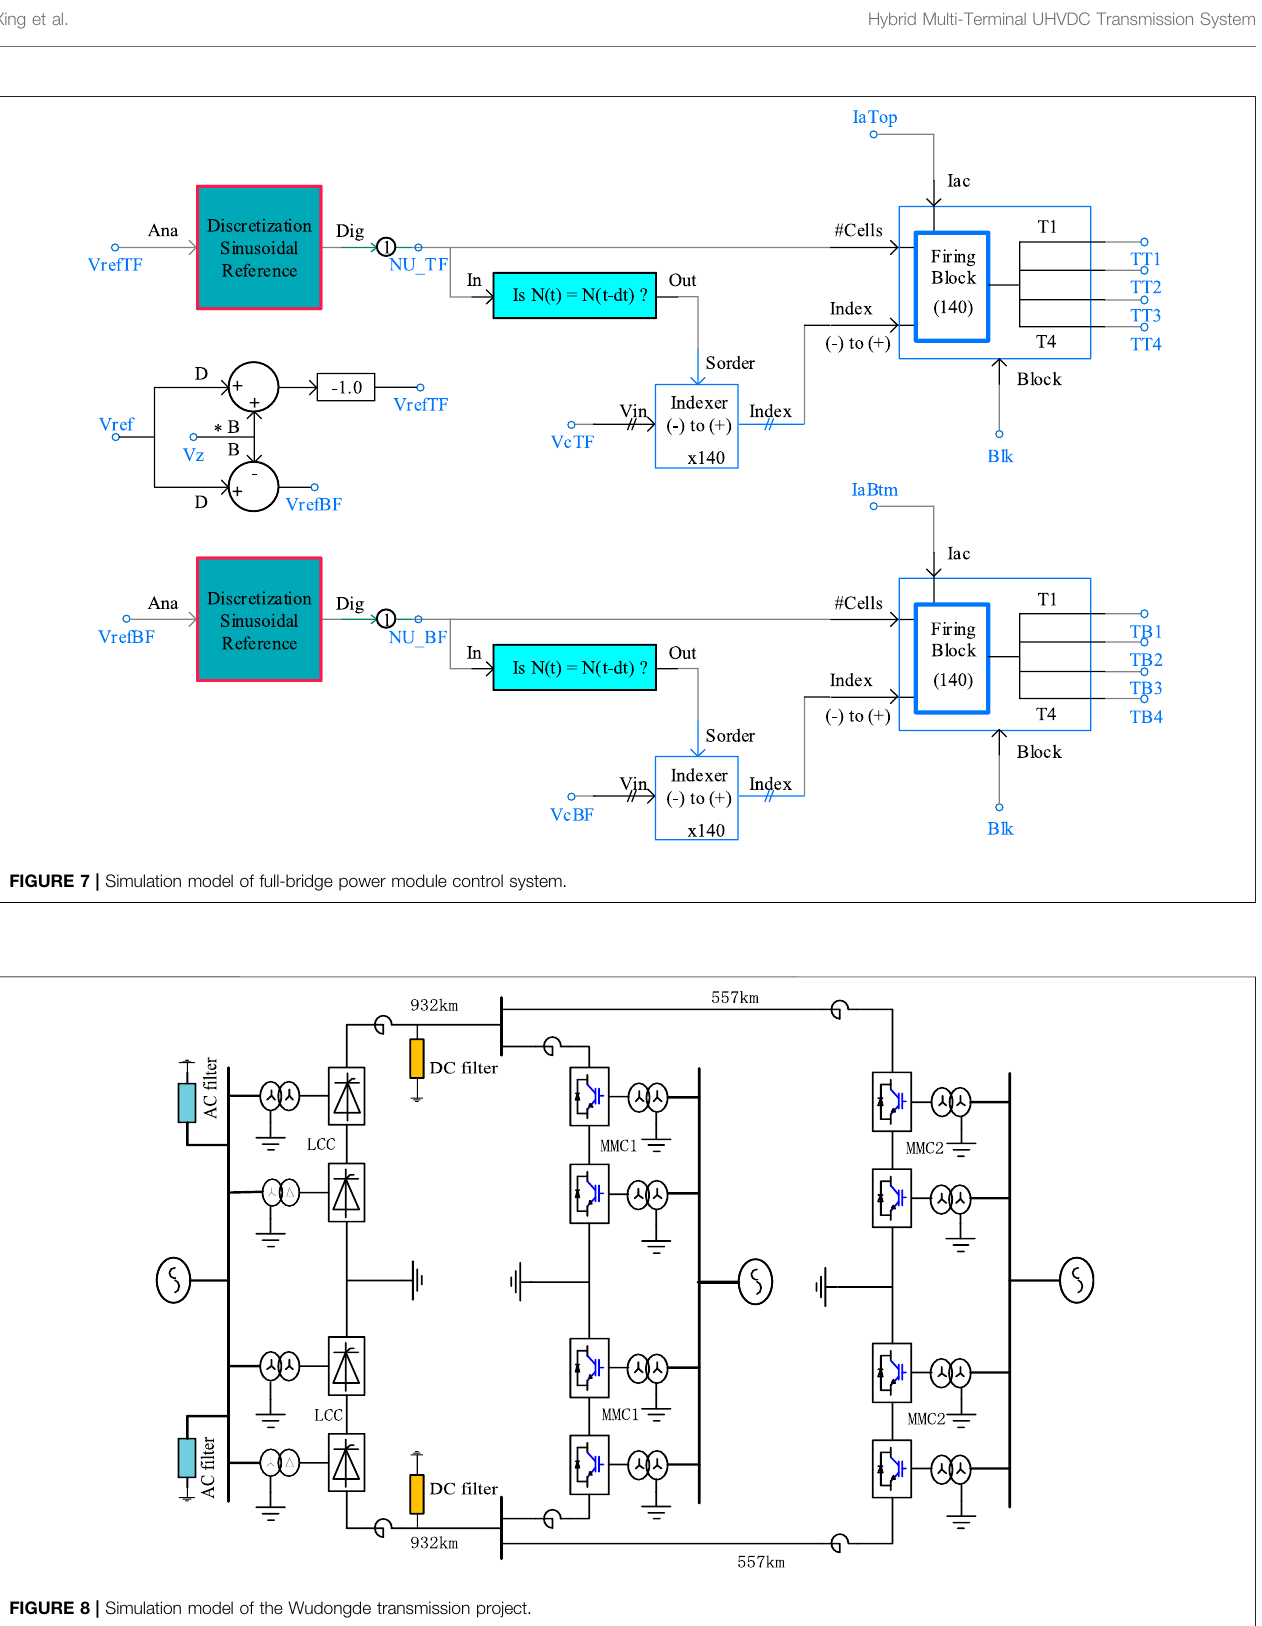
Frontiers in Energy Research |